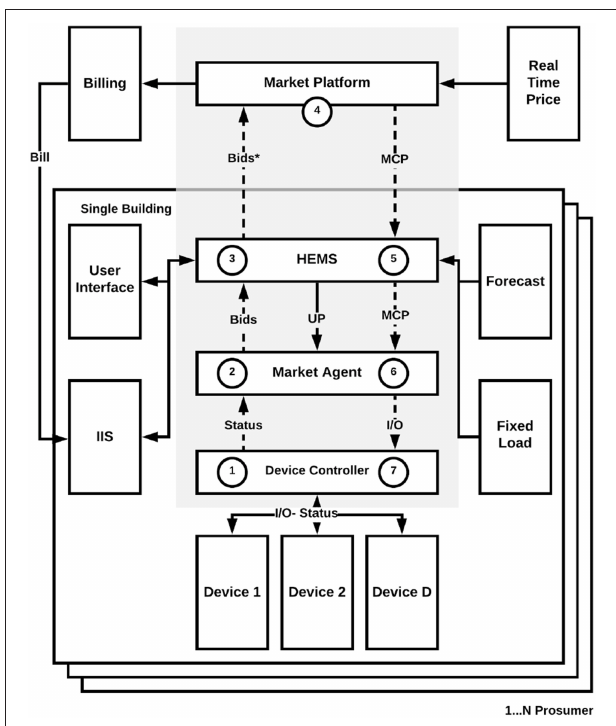
FIGURE 1 | An overview of the model structure and communication steps (El-Baz et al.,